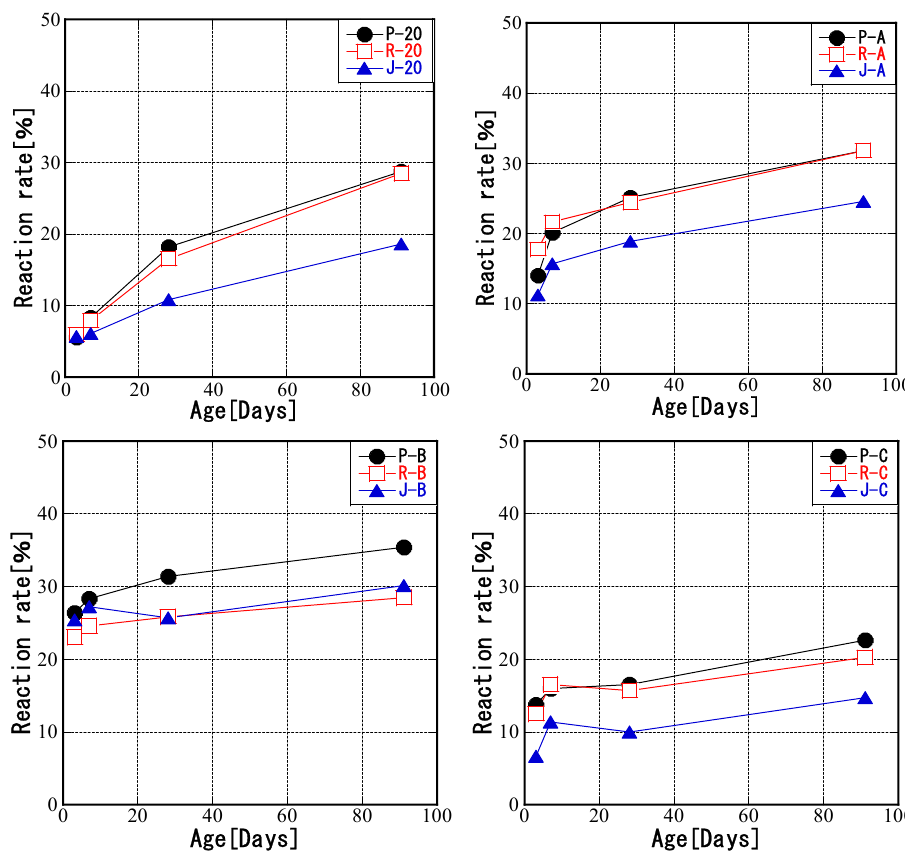
Figure 7. FA reaction